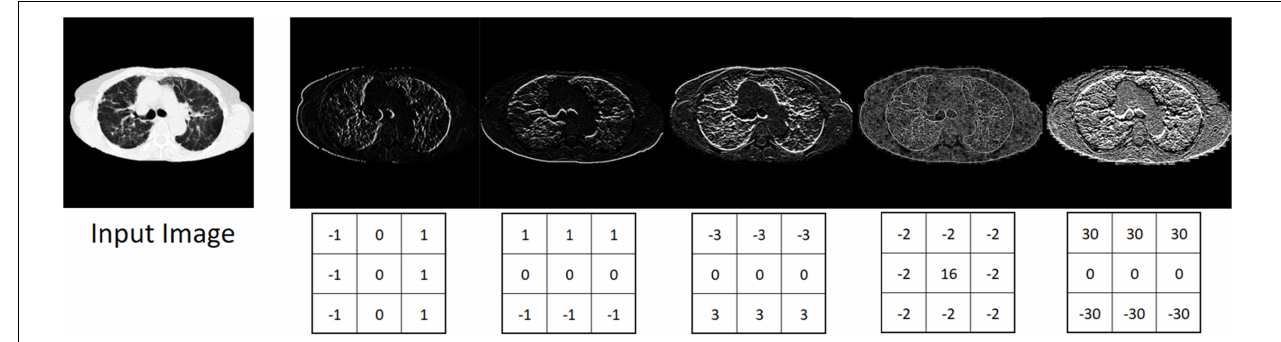
FIGURE 4 | Input image and five different output images generated with different convolution kernels.